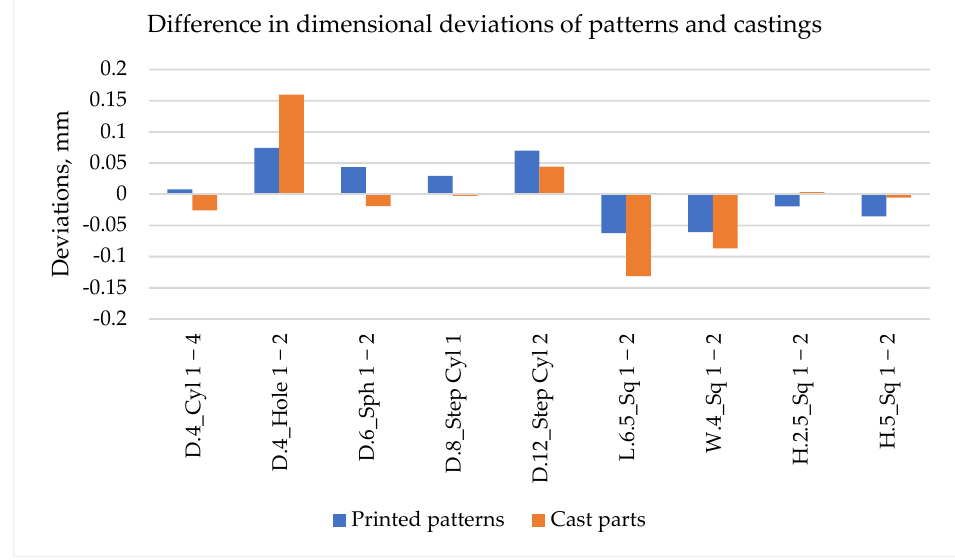
Figure 9 represents the comparison between dimensional deviation of printed patterns and cast parts.